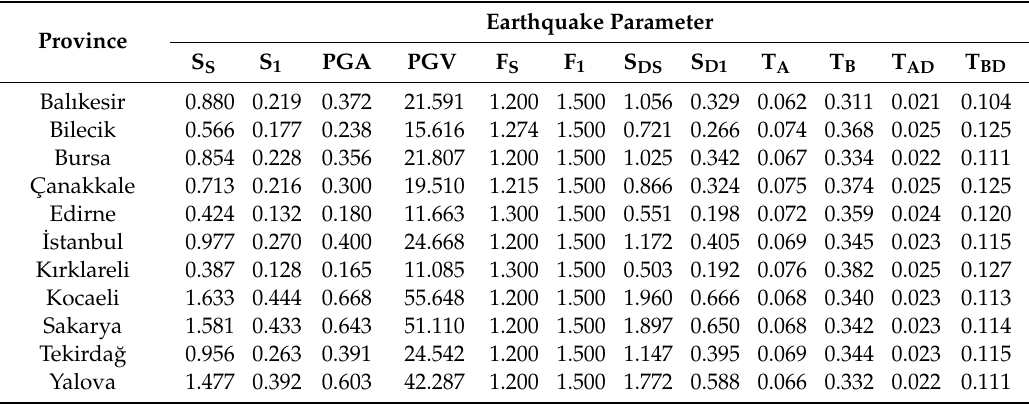
Table 6. Comparison of earthquake